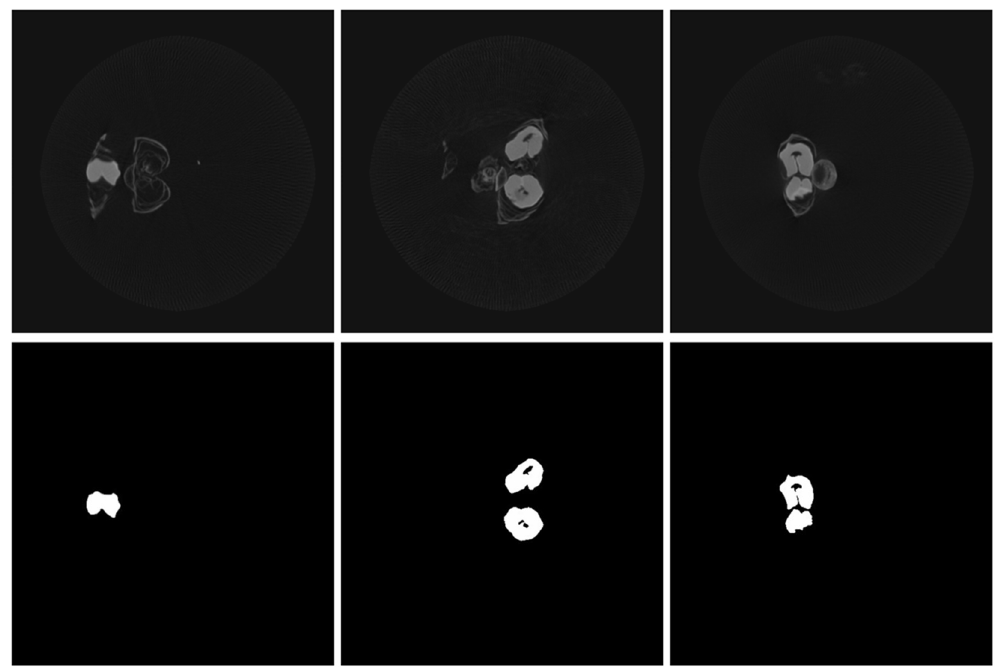
Figure 3. Labeled grains images. The top row images are sets of raw slices after holder clearance processing, and the bottom three are the corresponding three labeled binary slices.